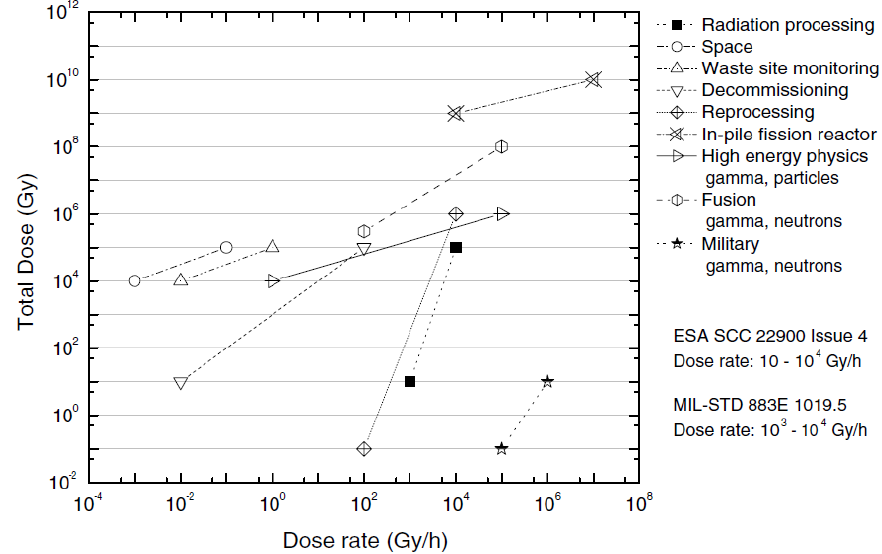
Figure 10. Overview of typical applications as a function of total dose and dose rate [98].